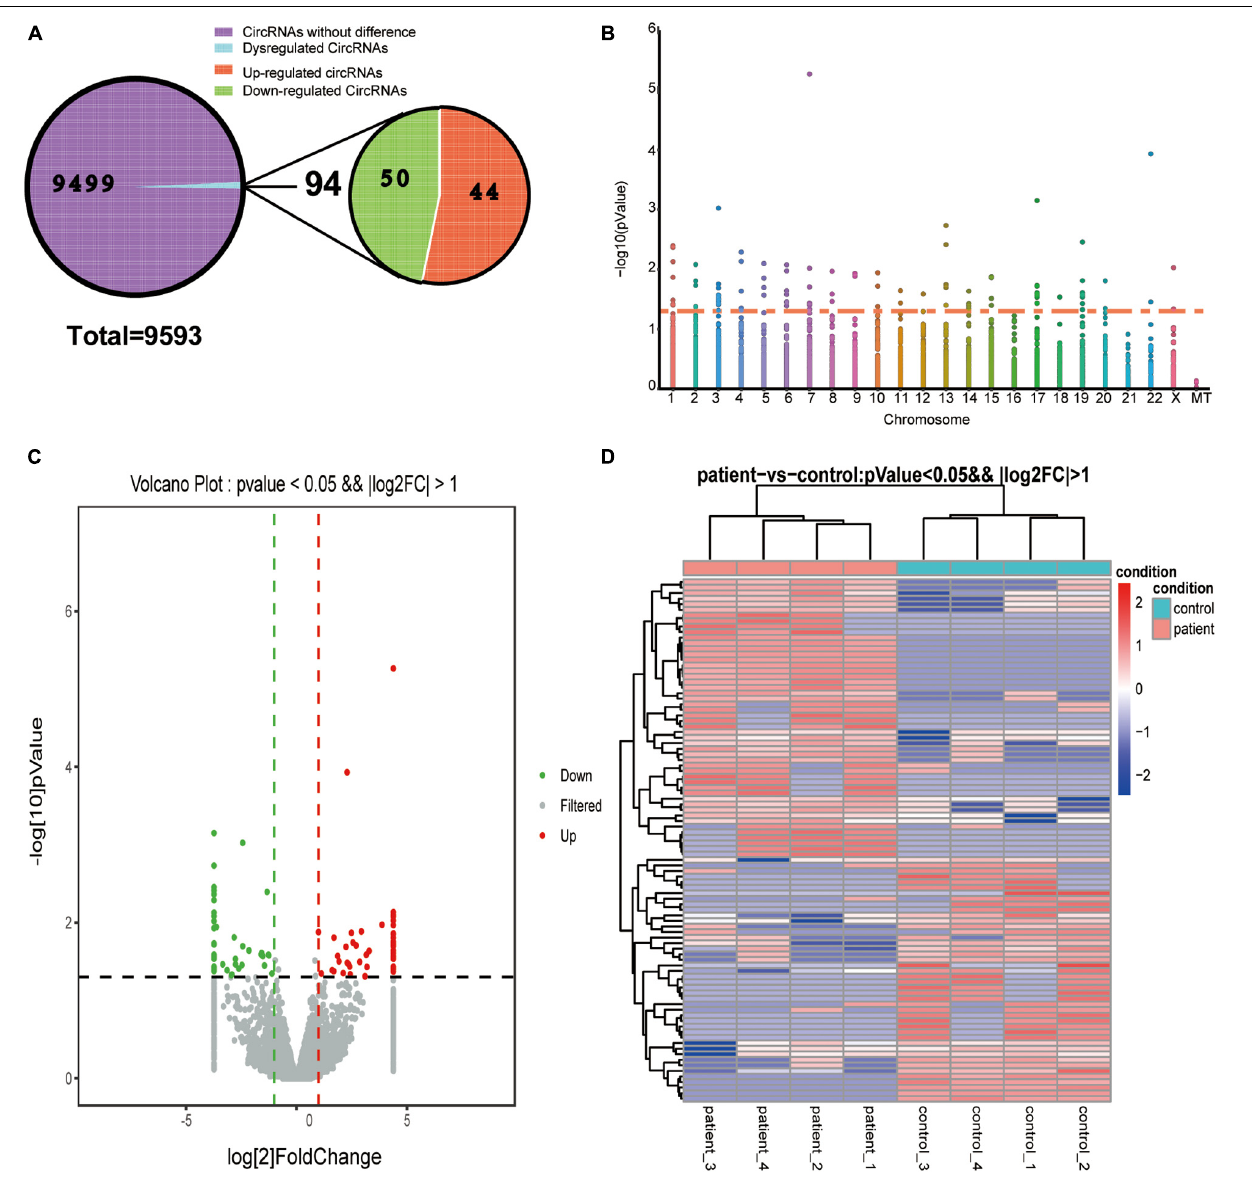
FIGURE 2 | Differentially expressed circRNAs. (A) Pie chart of circRNA expression classification. A total of 9,593 circRNAs were detected, of which 94 circRNAs were differentially regulated in the control and BD groups, containing 44 upregulated and 50 downregulated circRNAs. (B) Manhattan plot of DE-circRNAs across all chromosomes. Dots above the orange line represent DE-circRNAs. (C) Volcano plot of DE-circRNAs. Gray dots represent these circRNA that were not considerably differentially expressed. Green and red dots indicate significantly downregulated and upregulated DE-circRNAs, respectively. (D) Heat map of dysregulated DE-circRNAs. Rows and columns represent the genes and samples. The thresholds were a | log2FC| ≥ 1 and P -value ≤ 0.05.